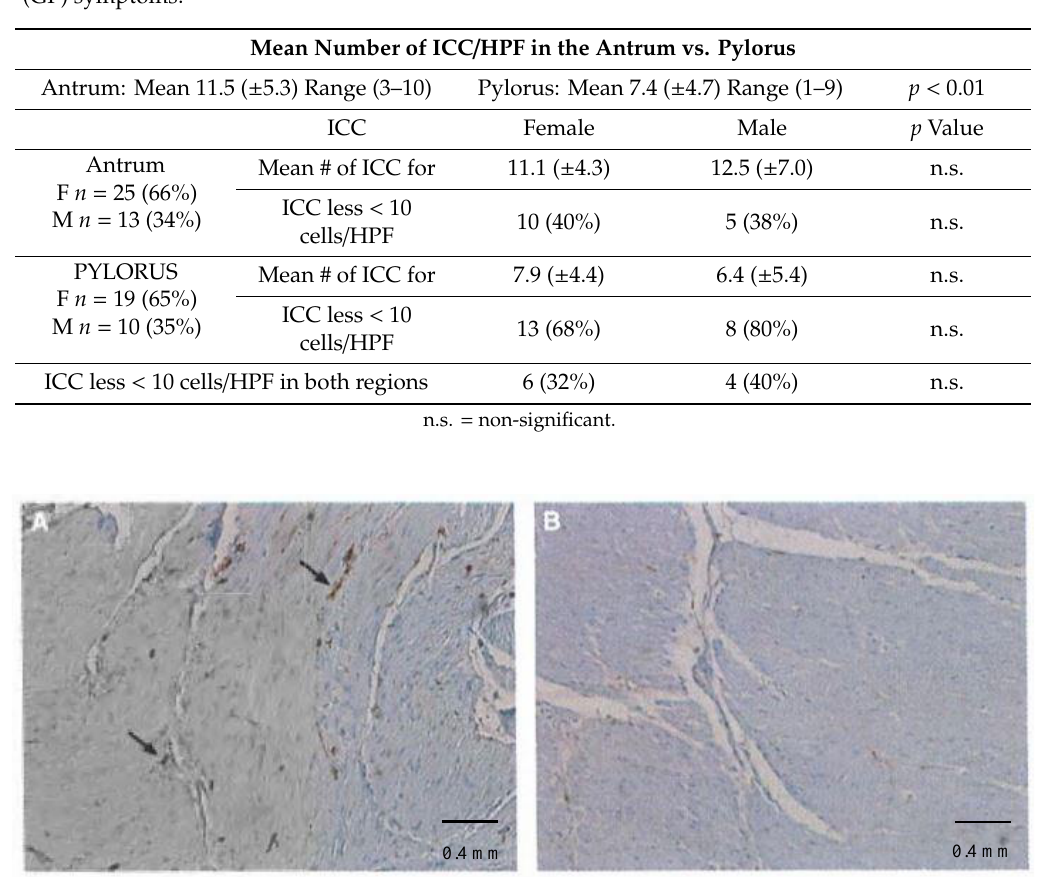
Figure 3. Pyloric interstitial cells of Cajal (ICC) in a control ( A ) compared to a gastroparetic patient ( B ) (20 × ). Pyloric ICC are depleted in this gastroparetic patient. Black arrows indicate c-Kit positive cells. Twenty-six diabetics (42% F, n = 16) provided adequately sized pyloric biopsies. In the pylorus, 68% of females had depletion of ICC ( < 10 cells / HPF), compared to 80% in males. The scale line represents 0.4 mm.